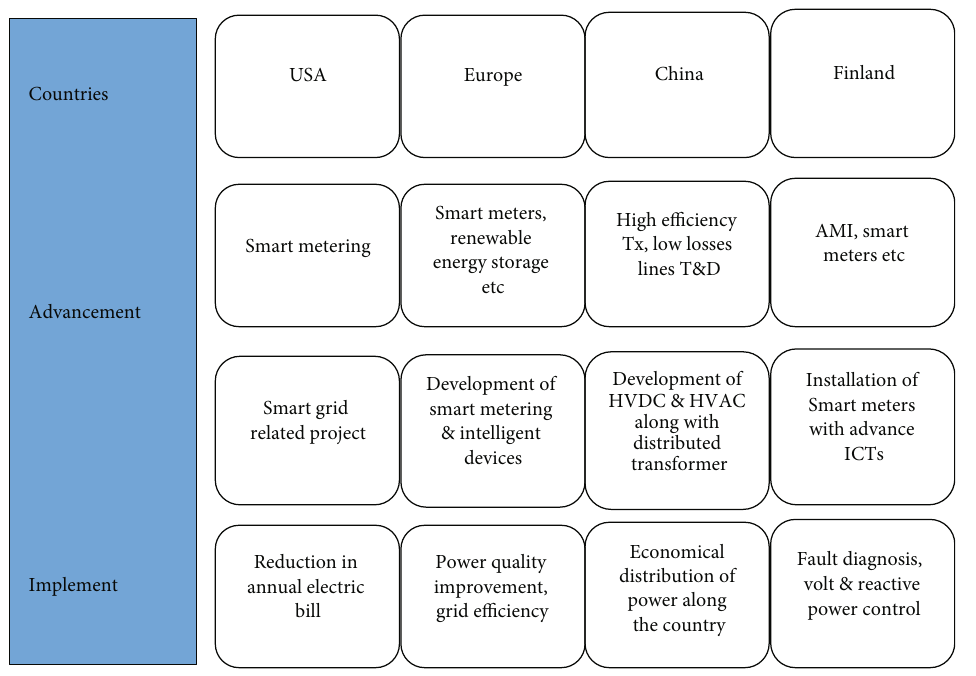
Figure 13: Smart grid development in major